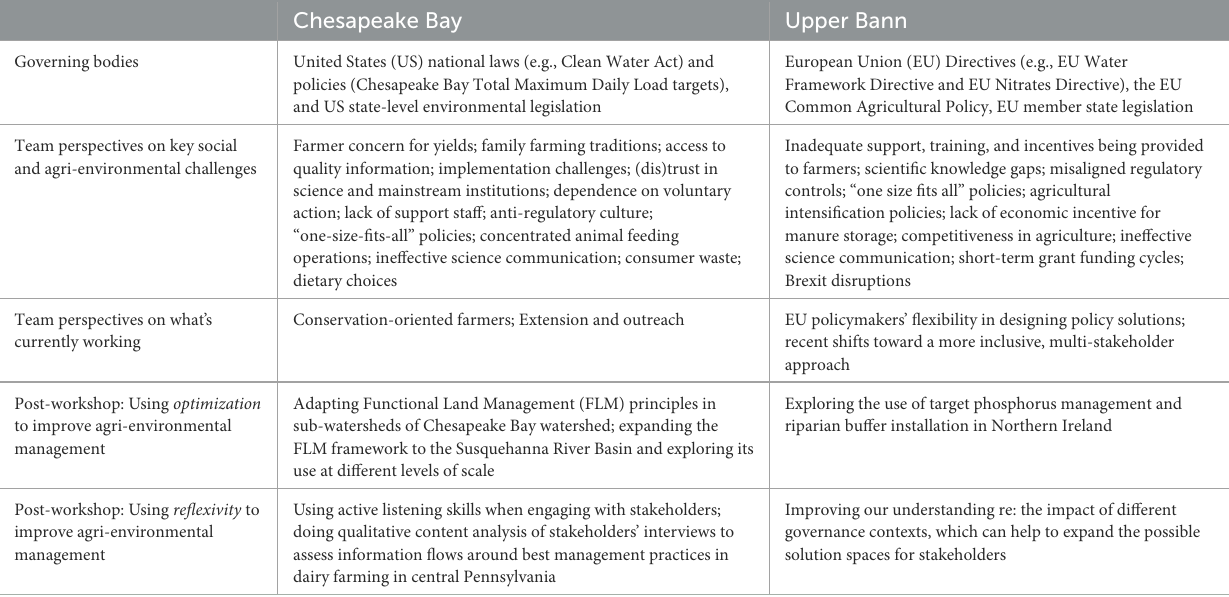
TABLE 1 Agri-environmental challenges in the Chesapeake Bay and Upper Bann: governance contexts, team perspectives, and post-workshop